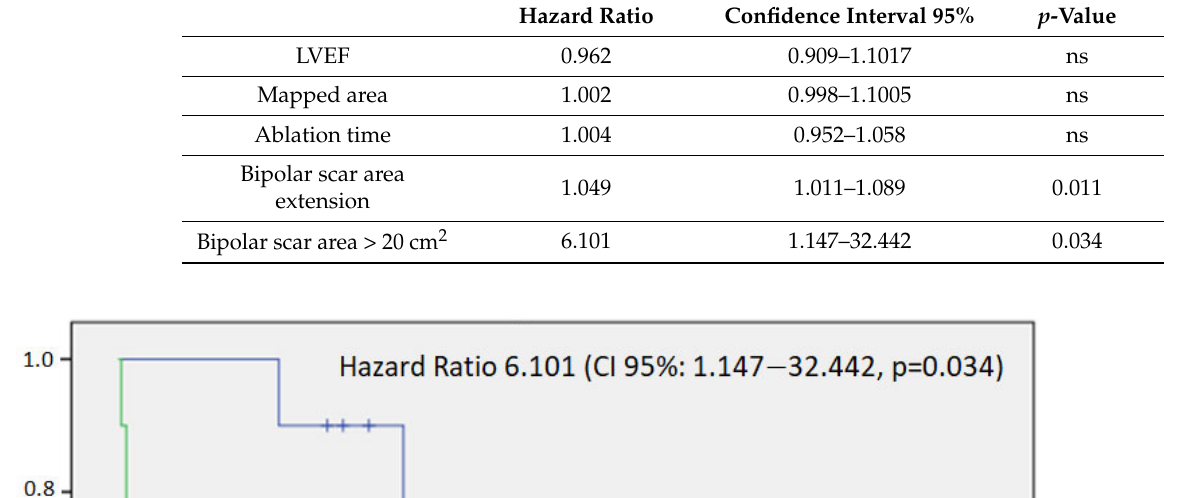
Table 3. Predictors of arrhythmia recurrence.